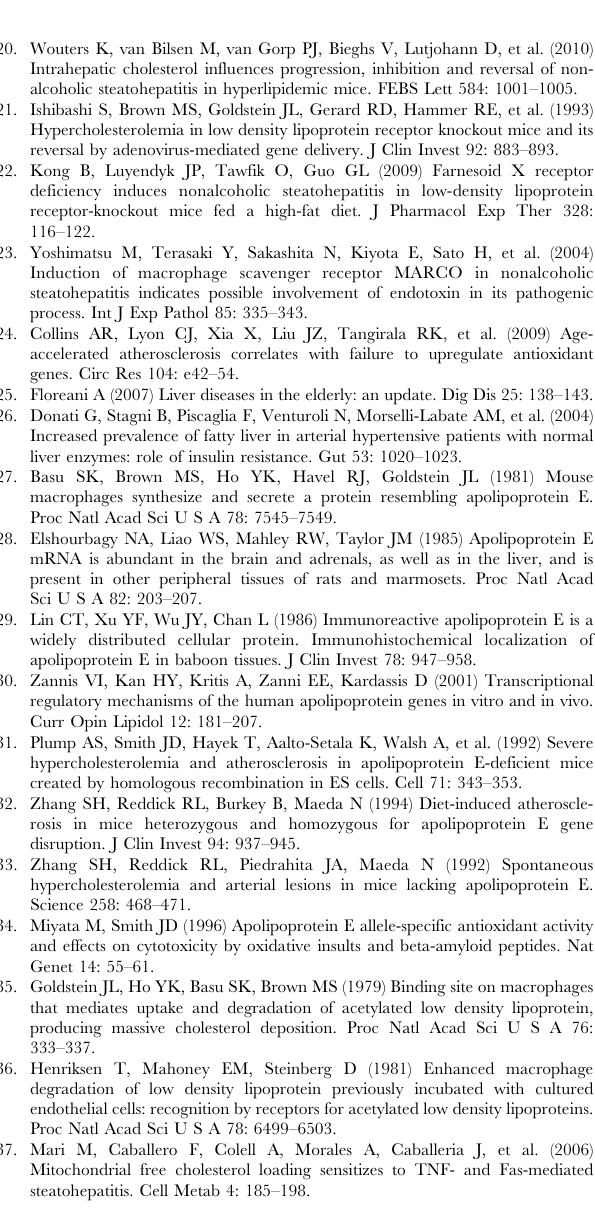
Figure S2 Weight. Relative weight gain after 3 months of HFC diet in C57Bl6, APOE2ki and Ldlr 2 / 2 mice. (TIF) Figure S3 Staining for activated hepatic stellate cells. The a SMA staining for activated hepatic stellate cells in C57Bl6, APOE2ki and Ldlr 2 / 2 mice after 3 months of HFC feeding. (TIF) Figure S4 Apoptosis. Representative pictures (200 6 magnifi- cation) of TUNEL stained liver sections of C57Bl6, APOE2ki and Ldlr 2 / 2 mice after 3 months of HFC feeding. (TIF) Figure S5 Plasma cholesterol levels and foamy Kupffer cells. (A) Plasma total cholesterol levels after chow and 3 months of the HFC diet in the three different models. (B) Representative pictures (magnification 6 200) after 3 months of the HFC diet for C67Bl6, APOE2ki and Ldlr 2 / 2 mice, respectively. * Significantly